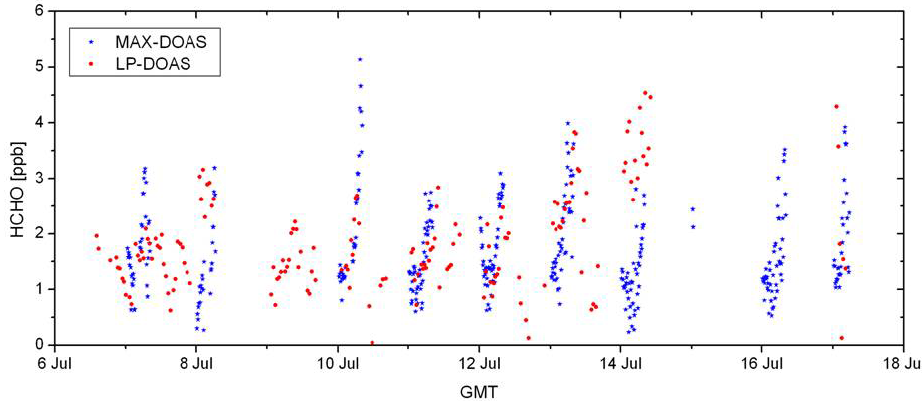
Fig. 8. Geometric conversion of the MAX-DOAS slant column densities at 2 ◦ elevation angle to mixing ratios assuming a block profile of 250m thickness, which are then compared with simultaneous LP-DOAS measurements.